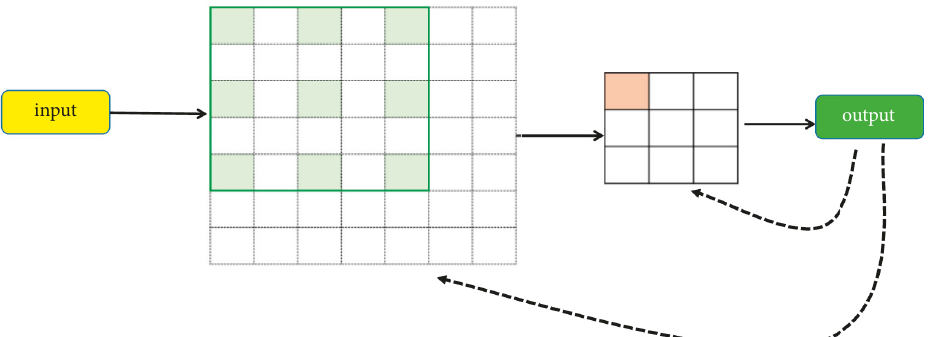
Figure 2: The working principle of the atrous convolution algorithm.